Question: Provide a publication-style caption for this figure.
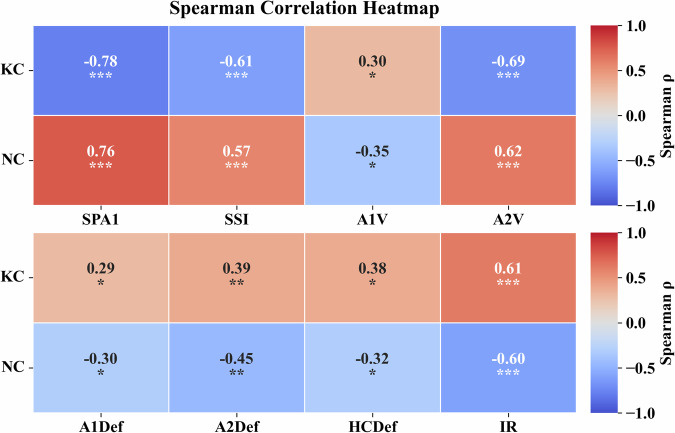
Answer: Spearman correlation heatmap between VST-derived features and biomechanical parameters (*** p < 0.0001; ** p < 0.001; * p < 0.01). A1V A1 Velocity, Corneal Apex Velocity at first Applanation, A2V A2 Velocity, Corneal Apex Velocity at second Applanation, A1Def A1 Deflection Amp, Deflection Amplitude at first Applanation, A2Def A2 Deflection Amp, Deflection Amplitude at second Applanation, HCDef HC Deflection Amp, Deflection Amplitude at Highest Concavity, IR Integrated Radius, Calculus of the radius of the reverse concavity, SPA1 Stiffness Parameter at first Applanation, SSI Stress-Strain Index.